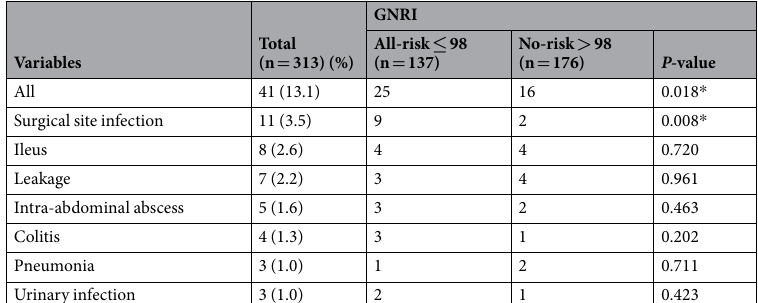
Table 3. The relationship between GNRI status and postoperative complications (CD grade ≥ II) in the elderly patients with CRC. GNRI = geriatric nutritional risk index, CD = Clavien-Dindo, CRC = colorectal cancer, Asterisk values indicate P-values < 0.05.